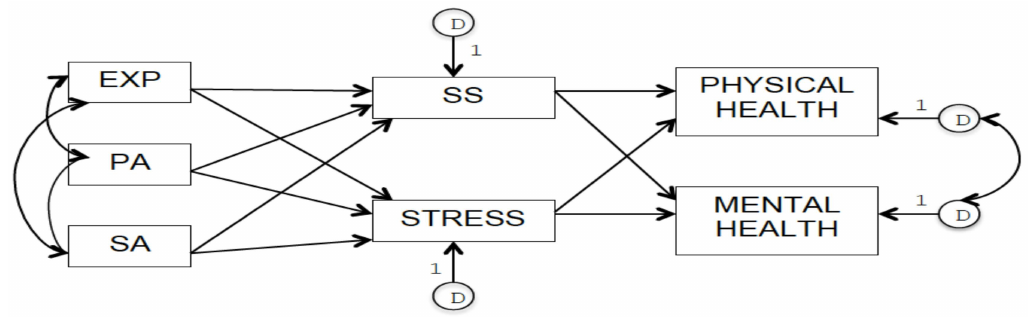
Figure 2. Model 2 representing indirect e ff ects of childhood exposure to IPV (EXP), physical abuse (PA), and sexual abuse (SA) on adult physical and mental health mediated by adult self-perceived social support (SS) and self-perceived everyday life stress